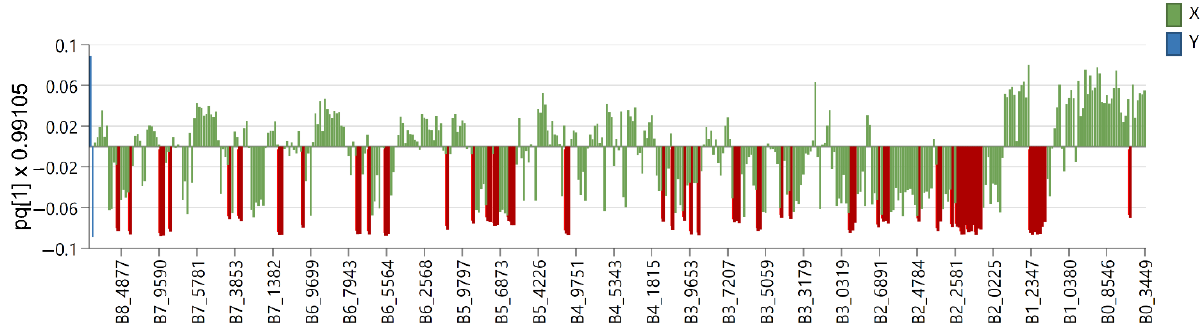
Figure 5. Loading plot with red and brown marked variables characteristic for E. salicifolia (Y variables—loading vectors scaled to unit length) in comparison to other species (X variables— chemical shift), obtained from the OPLS-DA model.